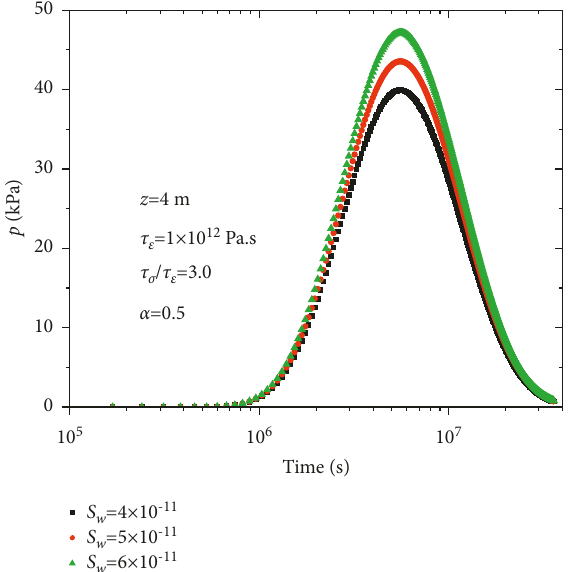
Figure 15: Influence of the phenomenological coefficient S